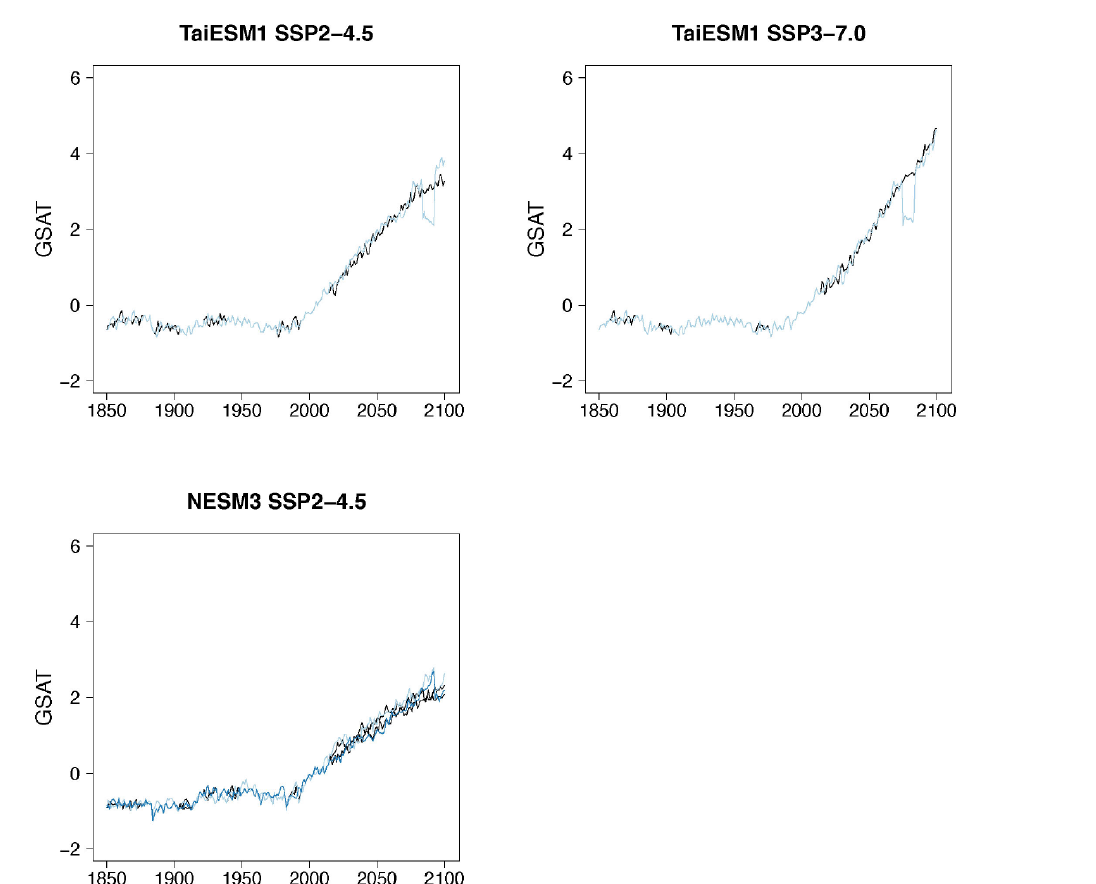
Figure B7. Examples of target (black lines) and stitched (colored) GSAT time series for ESMs in the PANGEO archive that ran at least one trajectory along the Tier 1 experiments of ScenarioMIP (SSP1-2.6, SSP2-4.5, SSP3-7.0, SSP5-8.5). We use the two bracketing scenarios and emulate trajectories that follow the two intermediate